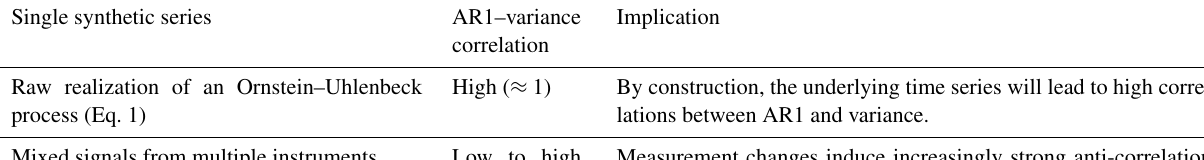
Table 1. Role of signal merging, signal-to-noise ratio (SNR), and multi-signal averaging in controlling AR1–variance correlations. Single synthetic